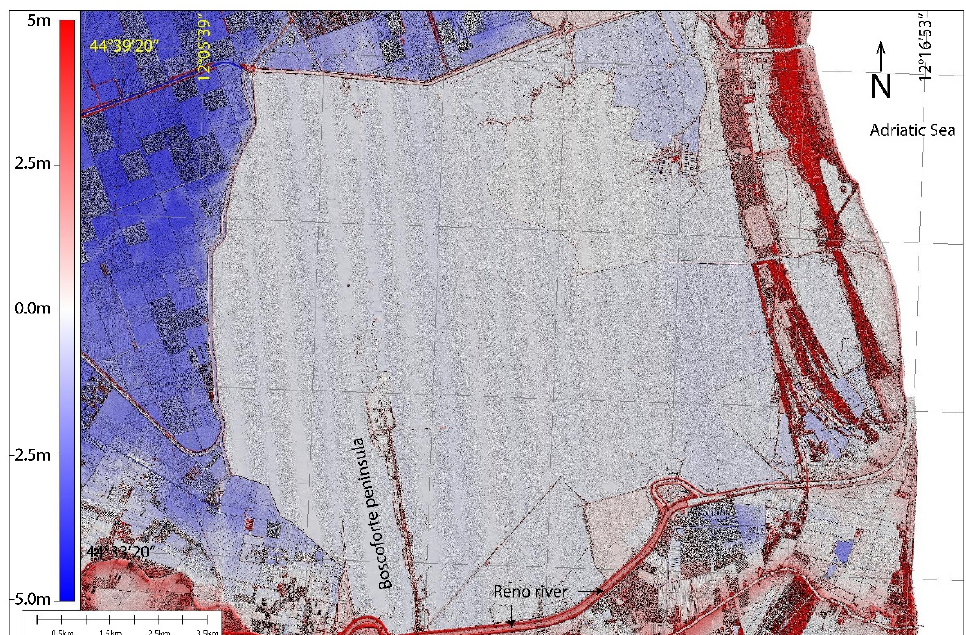
Figure 11. Lidar-based topographic model of the inlands surrounding the Valli di Comacchio lagoons. Red colored areas are above the average sea level, while blue color marks areas below.